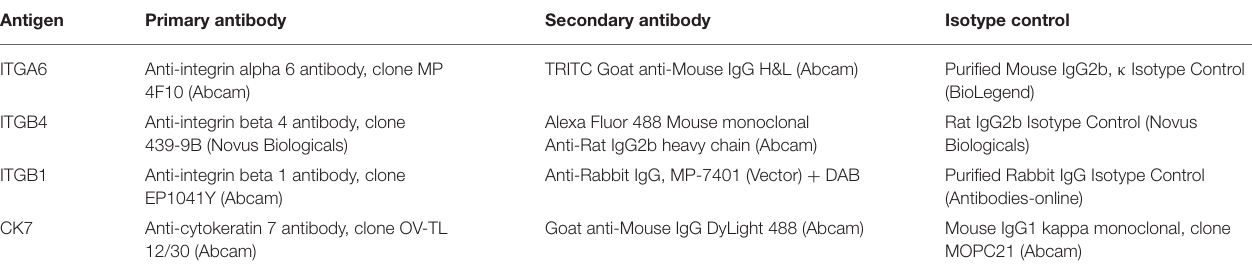
TABLE 1 | Antibodies and isotype controls used for immunodetection of integrin subunits and CK-7. Antigen Primary antibody Secondary antibody Isotype control